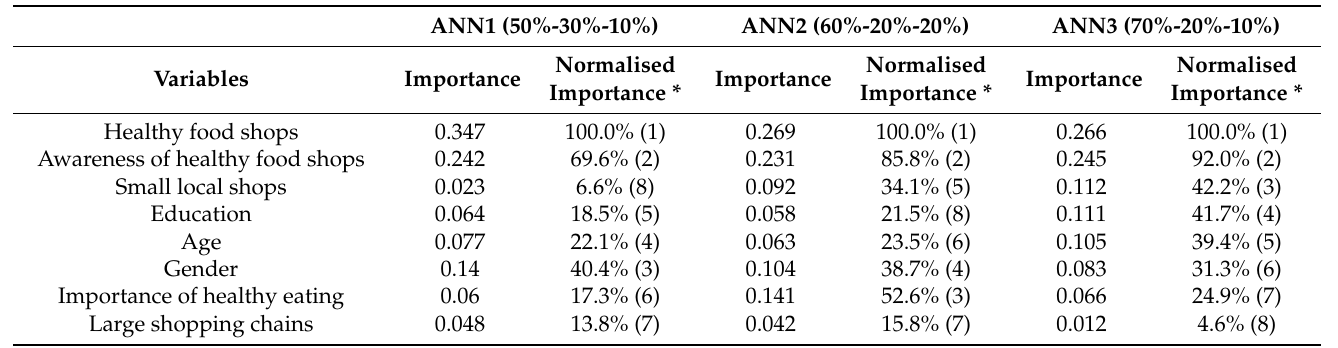
Table 7. Independent variable importance for the organic food consumption in the ANN models.